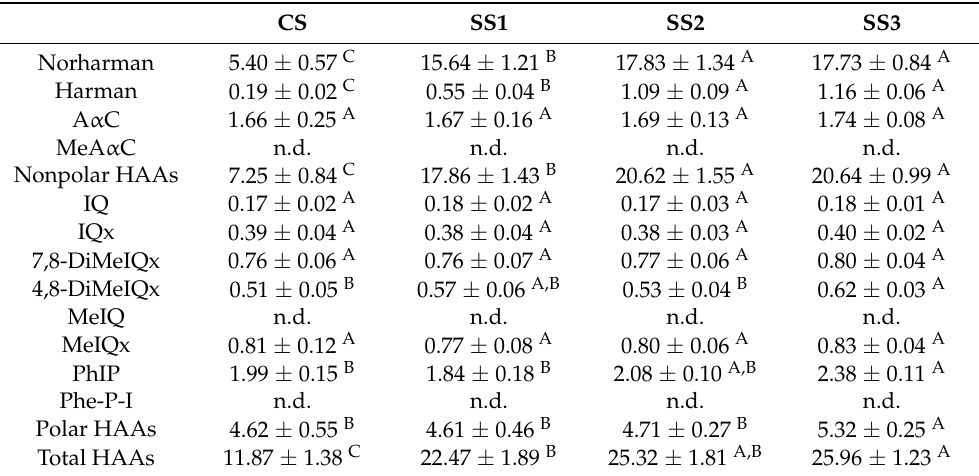
Table 3. Influence of the partial replacements of NaCl by KCl on the HAAs content (ng/g) of pan-fried